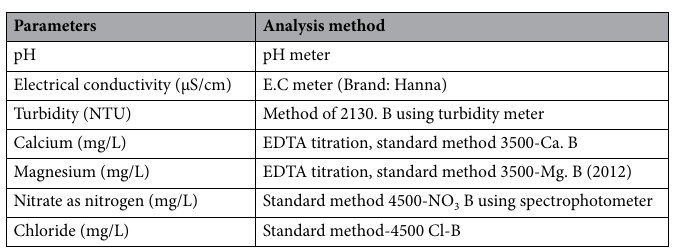
Table 1. Water quality parameters and methods of analysis (APHA, 23rd